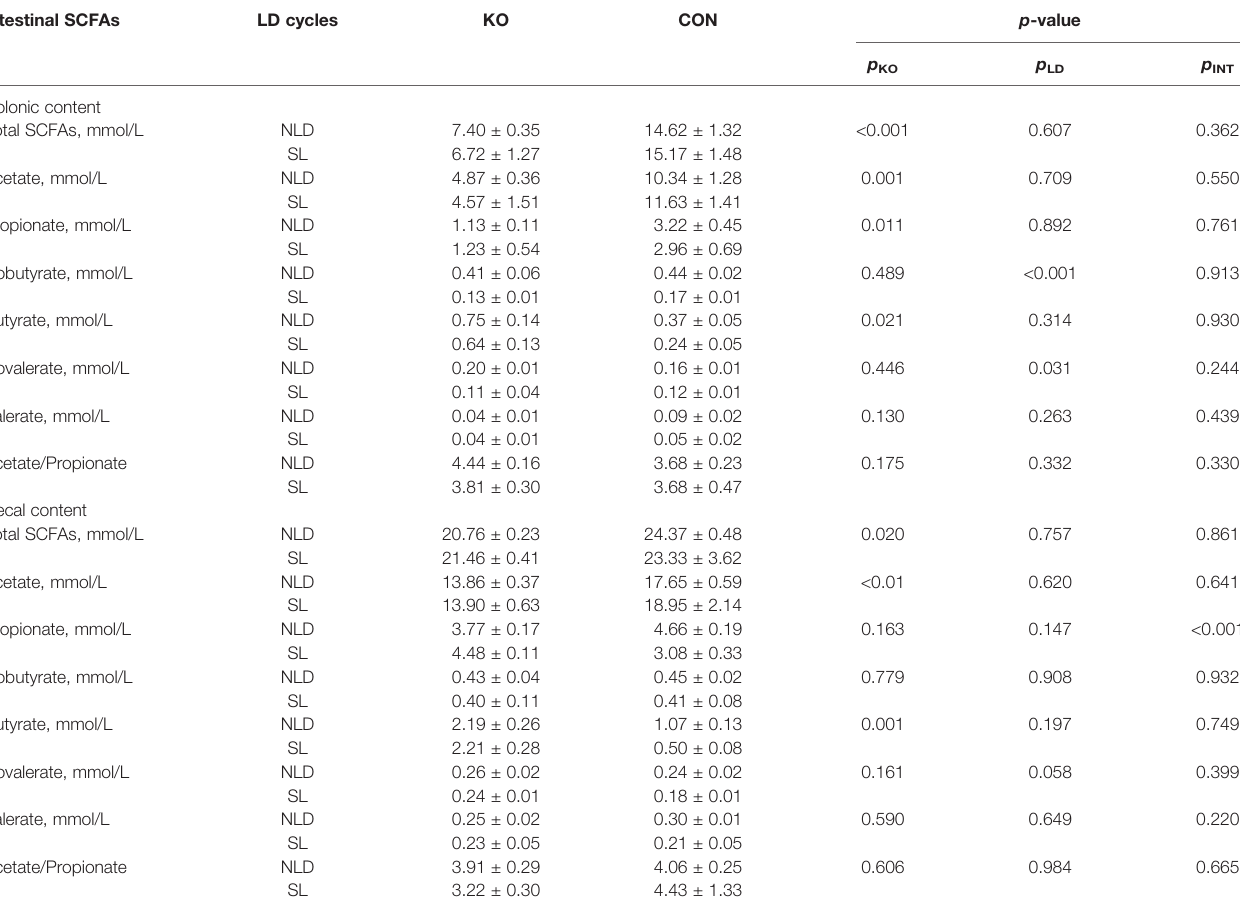
TABLE 2 | Concentrations of SCFAs in colonic and cecal contents. Intestinal